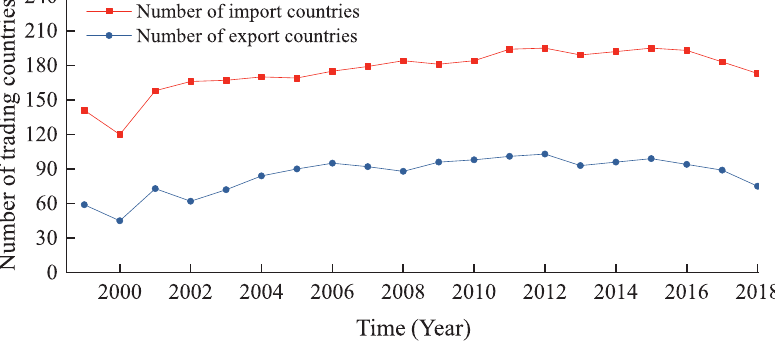
Figure 4. Evolution of the number of trading